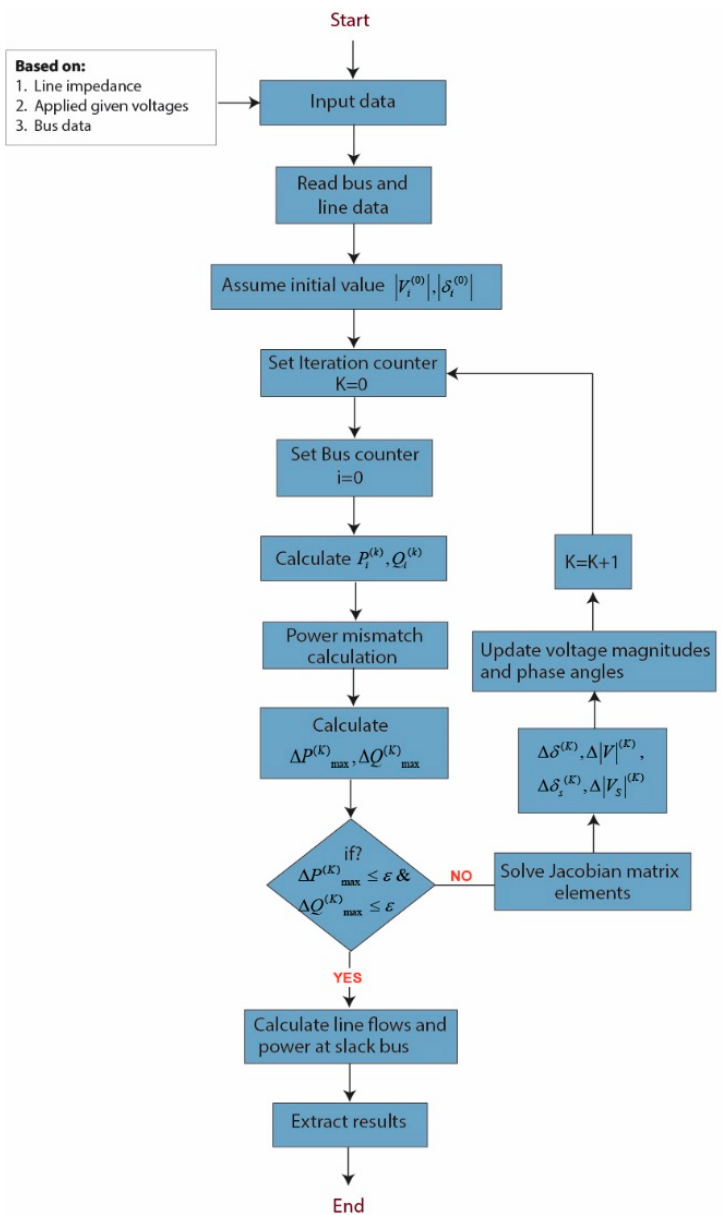
Figure 2. Flow chart for the load flow of the Newton–Raphson method.